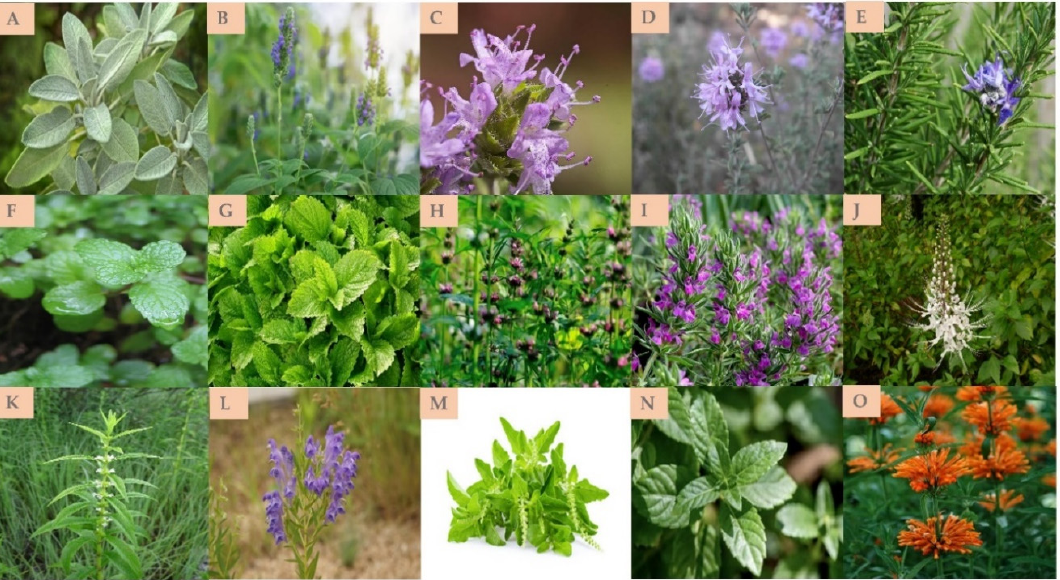
Figure 3. A Group of Lamiaceae plants (Available online: www.theplantlist.org) included in